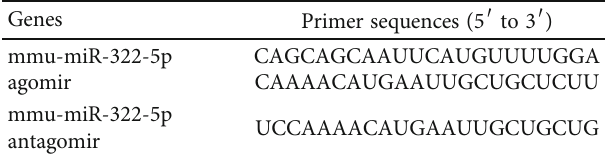
Figure 3: The Sox9/miR-322-5p/Smad7 axis was con fi rmed by qPCR, WB, and dual-luciferase reporter assay. (a) Relative expression levels of miR-322-5p among groups at di ff erent time points. (b) Predicted consequential pairing of Smad7 and miR-322-5p. (c) Dual-luciferase reporter assay con fi rmed the targeting relationship between Smad7 and miR-322-5p. (d) qPCR revealed the silencing e ff ect of miR-322- 5p on Smad7. (e, f) Results of WB were consistent with those of qPCR. Agomir represents mimics of miR-322-5p; antagomir represents blocker of miR-322-5p. ∗ p < 0 : 05 , ∗∗ p < 0 : 01 , and ∗∗∗ p < 0 : 0001 . NC: negative control; B2: BMP2. Table 2: The sequences used for miR-322-5p function regulation. Genes Primer sequences (5 ′ to 3 ′